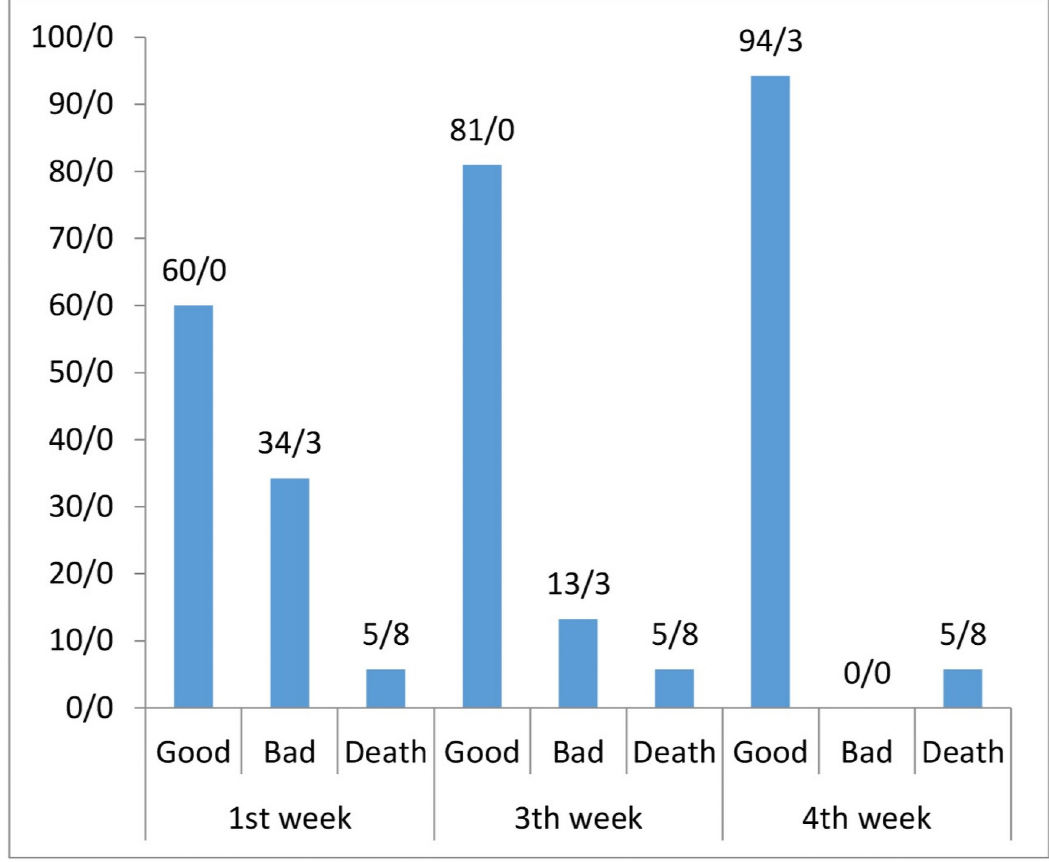
Fig 1. The frequency of mortality